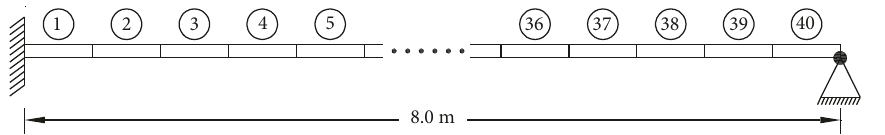
Figure 1: 40-element